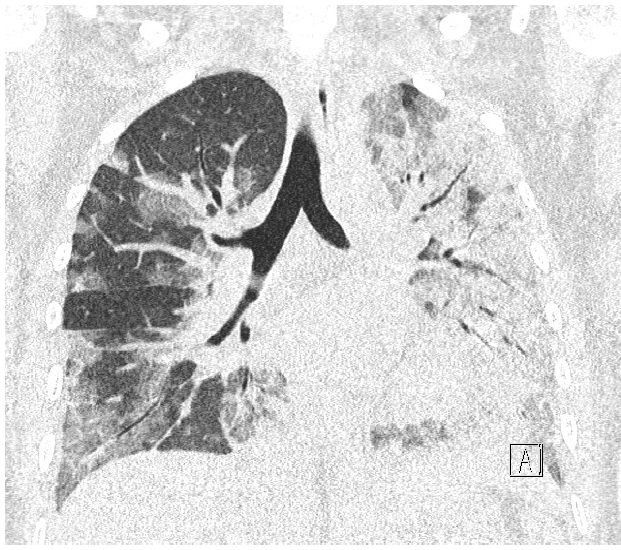
Figure 5. Chest Computed Tomography (HRCT).